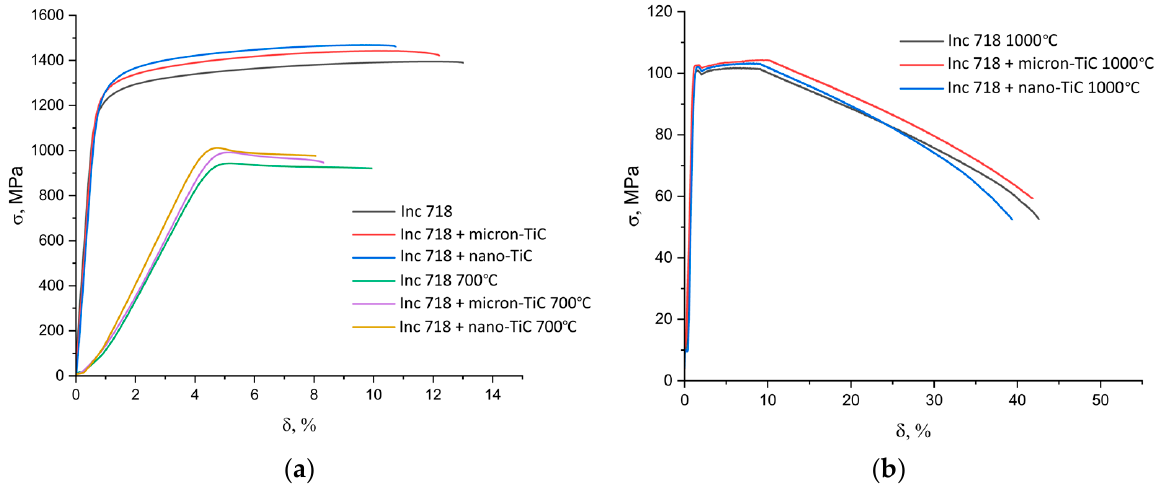
Figure 8. Engineering stress–strain curves for post-processed samples tested at room temperature and 700 °C ( a ) and 1000 °C ( b ).